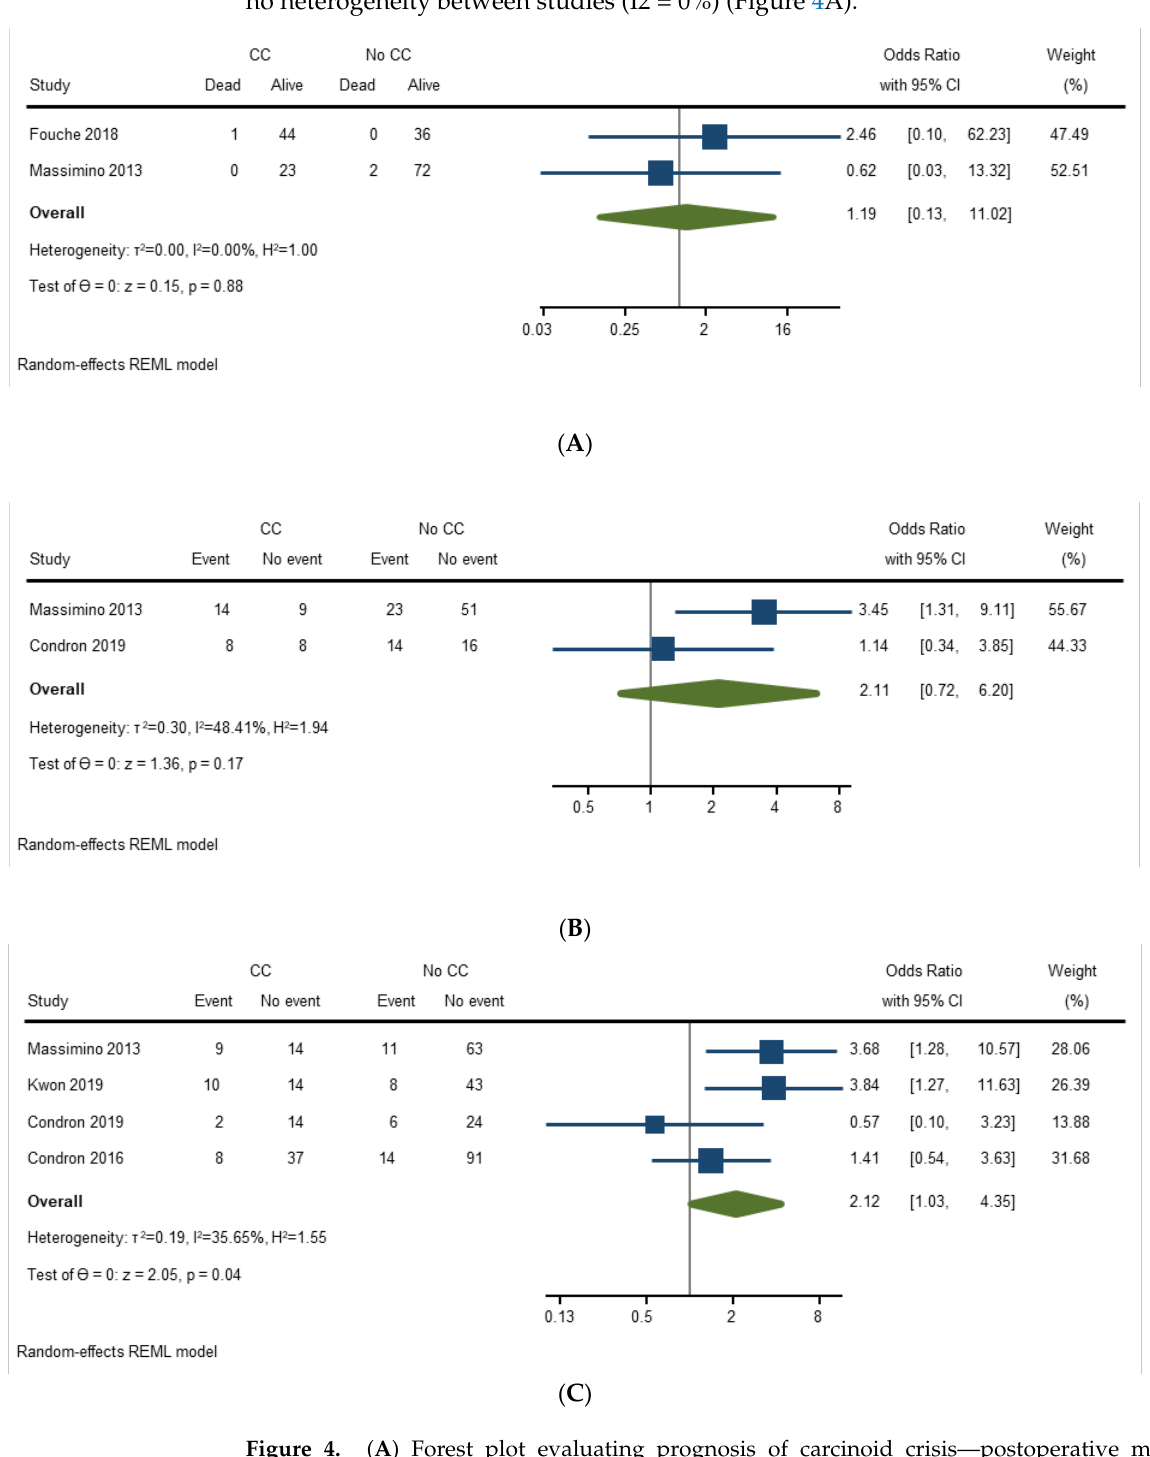
operative complication. Carcinoid crisis compared to no carcinoid crisis was not